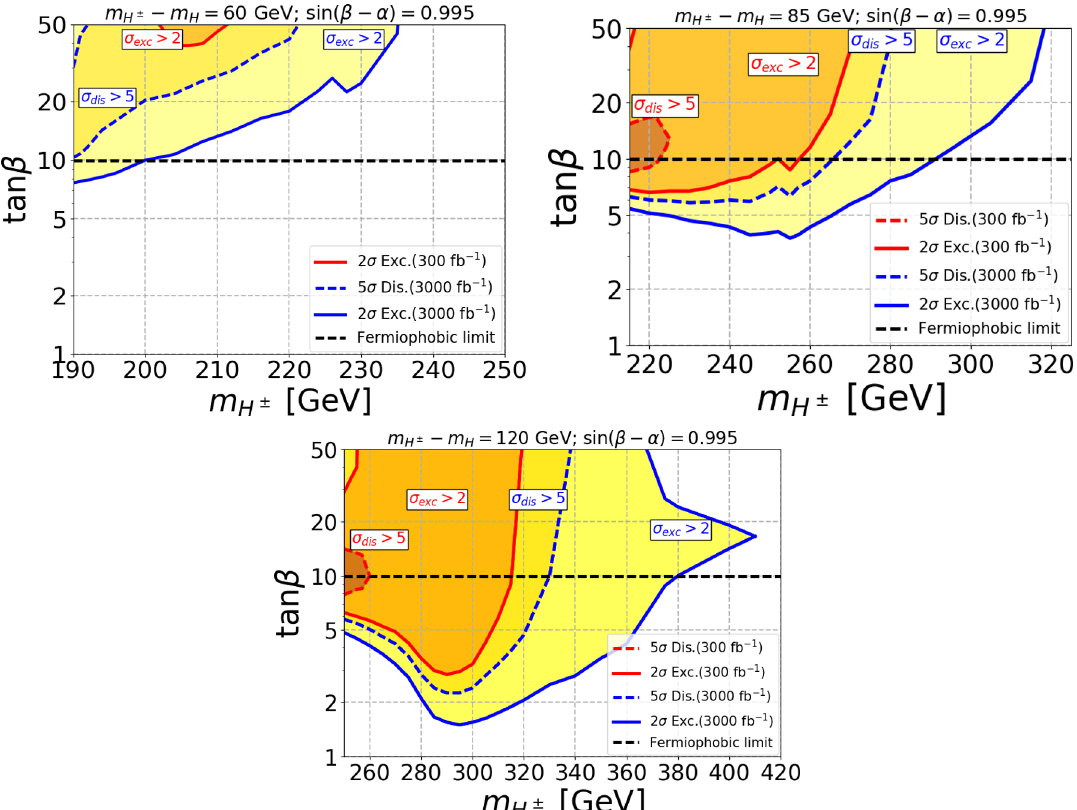
Figure 5 . The exclusion and discovery limits on the ( m − tan β ) parameter space for 300 fb − 1 H ± √ and 3000 fb − 1 lumiosities at s = 13 TeV for three mass differences, 60 GeV (top left) 85 GeV (top right) and 120 GeV (bottom) are given. The parameter sin( β − α ) = 0 . 995 leads to the fermiophobic limit of the heavy Higgs at tan β ∼ 10 as shown by the black dashed